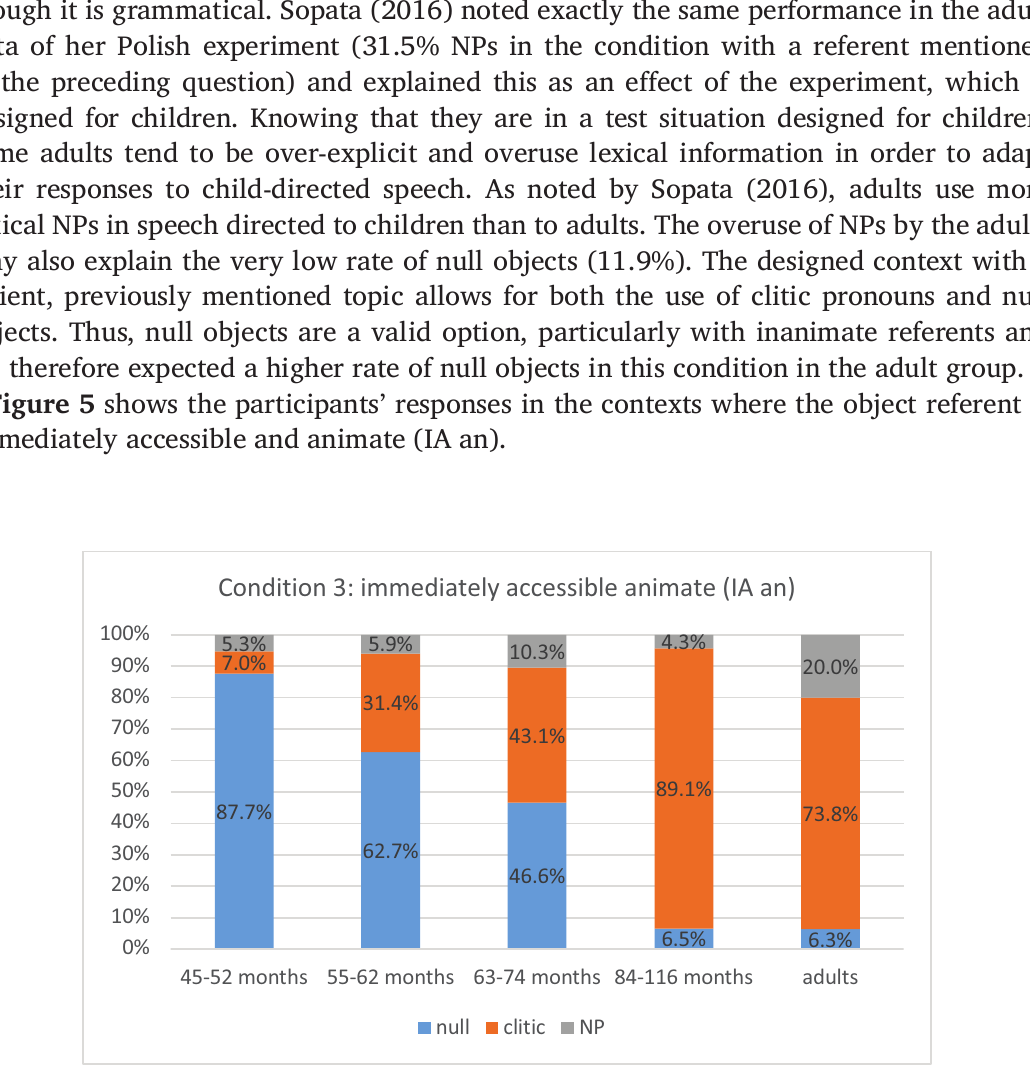
Figure 5: Distribution of null, clitic and NP objects in Condition 3 (IA